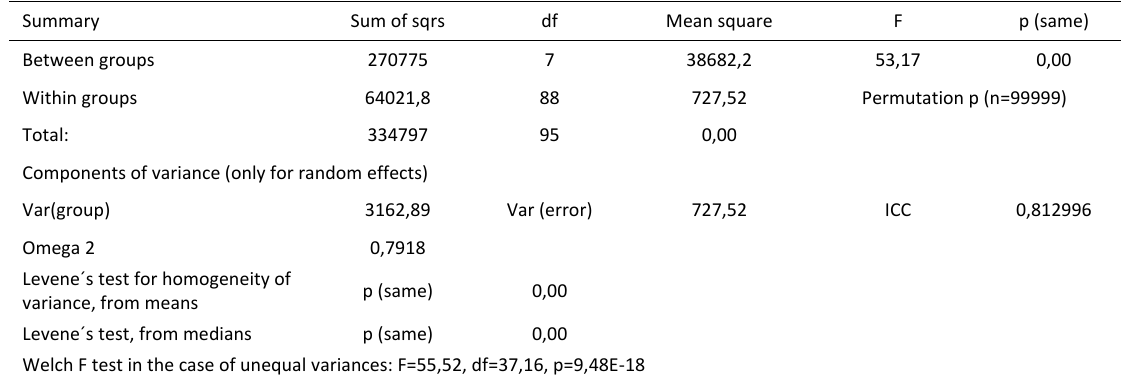
Tabel 3: Anova one way between medium